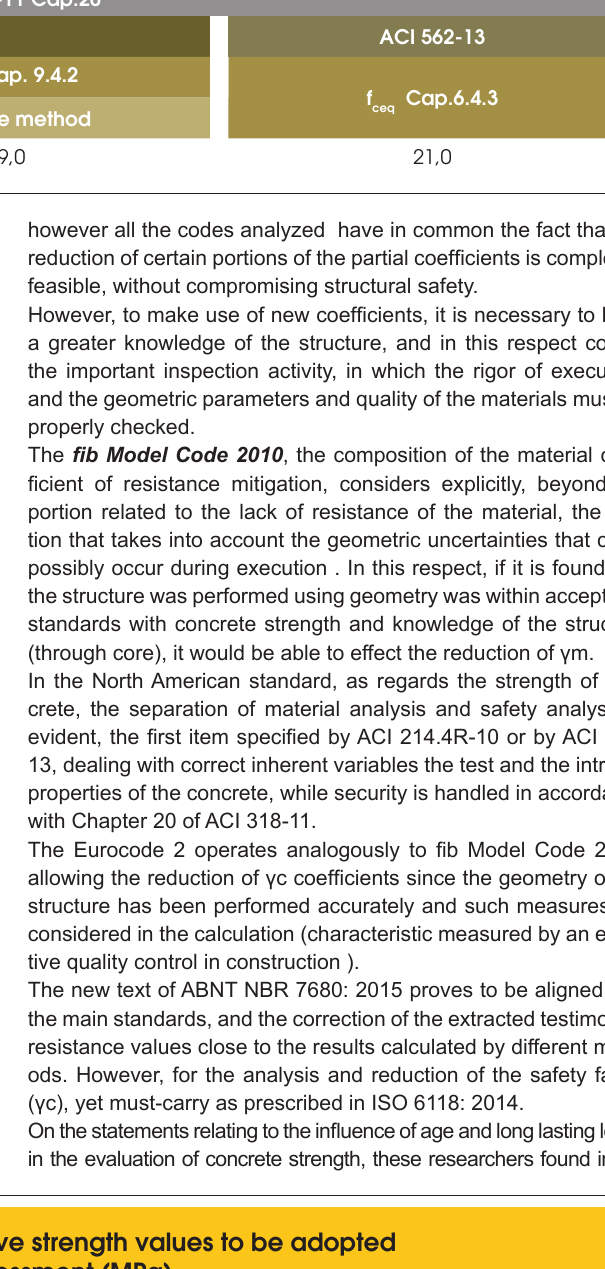
Table 11 – Concrete compressive strength values to be